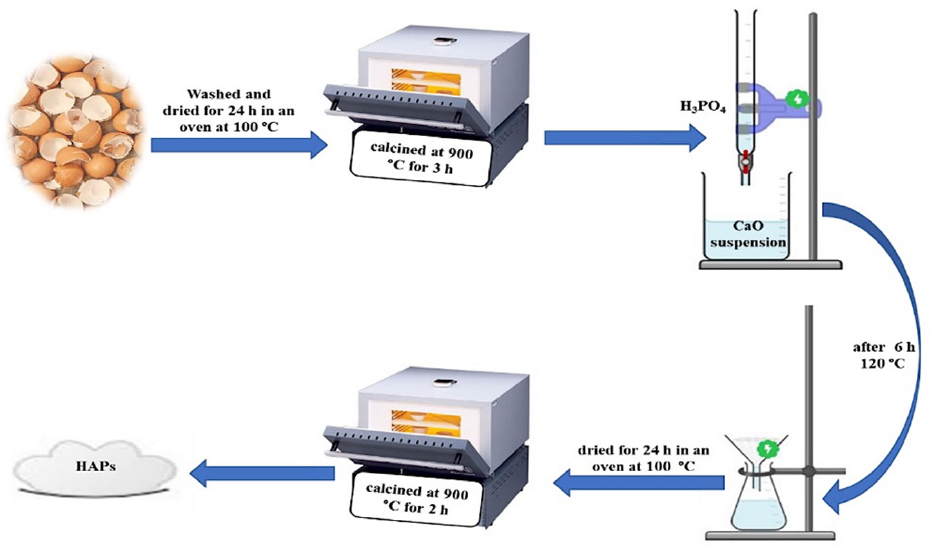
Figure 1. The schematic diagram of HAP